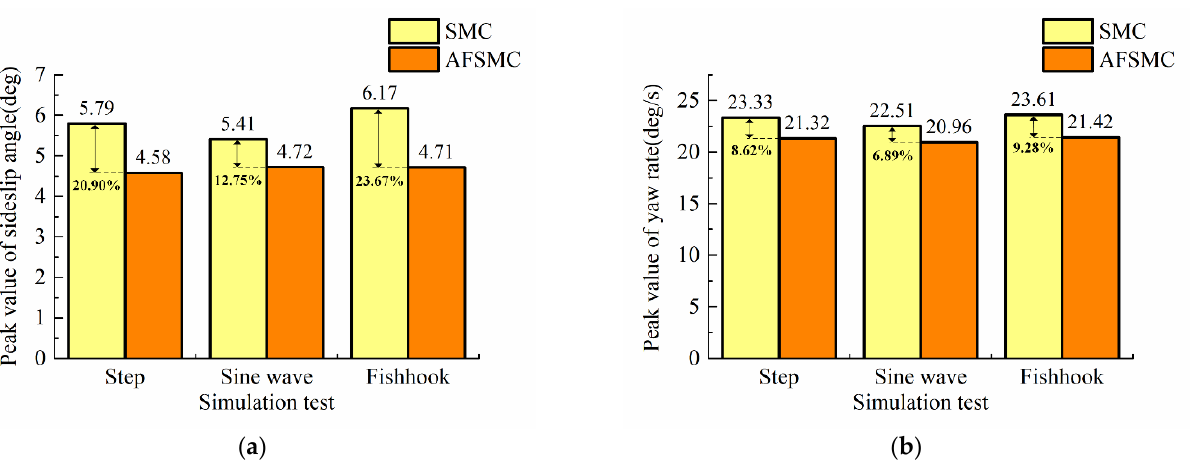
Figure 10. The peak values under different simulation tests. ( a ) Sideslip angle; ( b ) yaw rate.